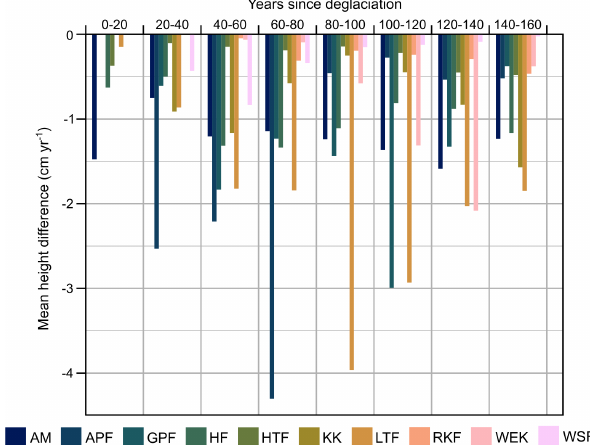
Figure 12. Mean annual height difference (based on the DoDs of the study areas covering time period 2; see Table 4 for specific DoDs) for different 20-year groups since deglaciation (relating to the mean year of the used DoD; colour map batlow10 from Crameri et al.,